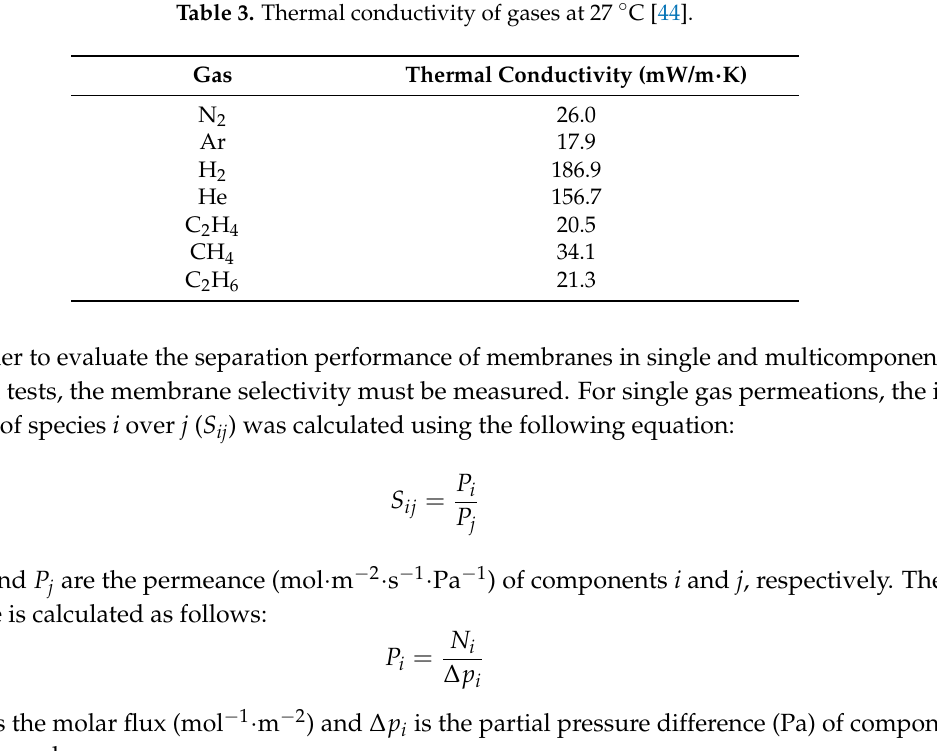
Table 3. Thermal conductivity of gases at 27 ◦ C